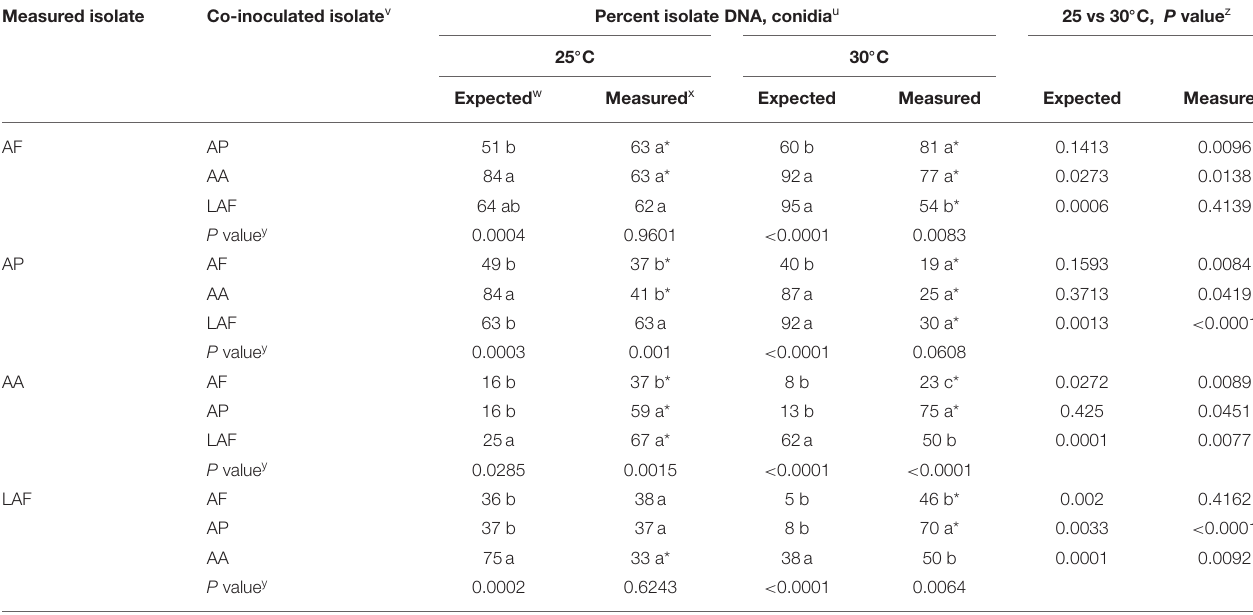
TABLE 3 | Influence of temperature on predicted and measured conidia percentages from paired co-inoculation of Aspergillus isolates at 25 and 30 ◦ C. Measured isolate Co-inoculated isolate